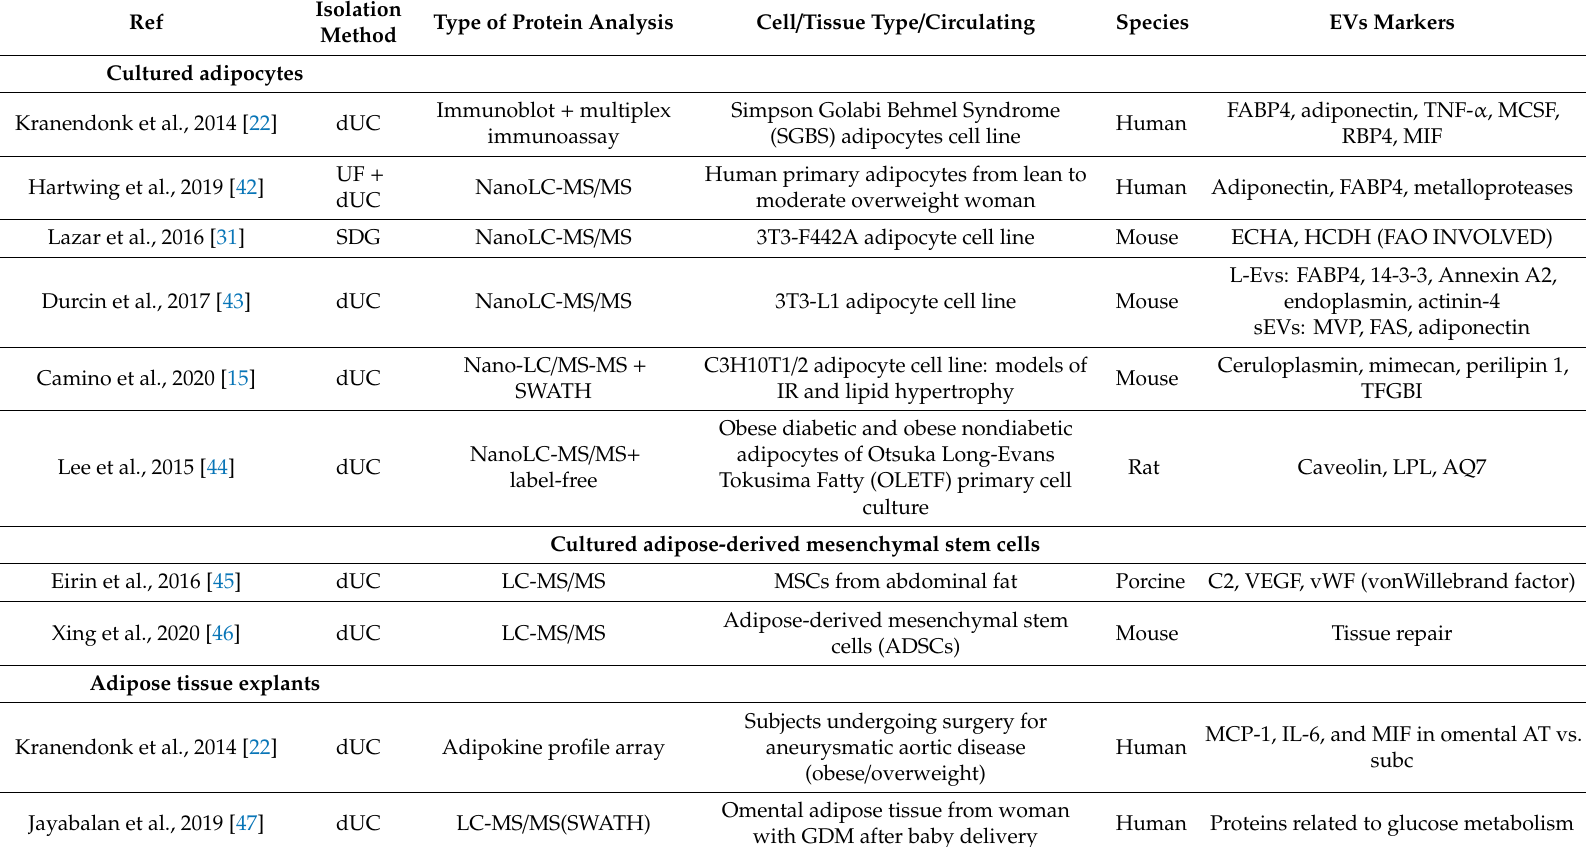
Table 1. Overview of revised publications related to adipose tissue EVs protein cargo characterization. Reference, method of EV isolation, type of protein analysis, type of cell / tissue or circulating analysis, species, and propose EVs markers are shown. dUC: di ff erential ultracentrifugation; SDG: Sucrose density grandient; UF: